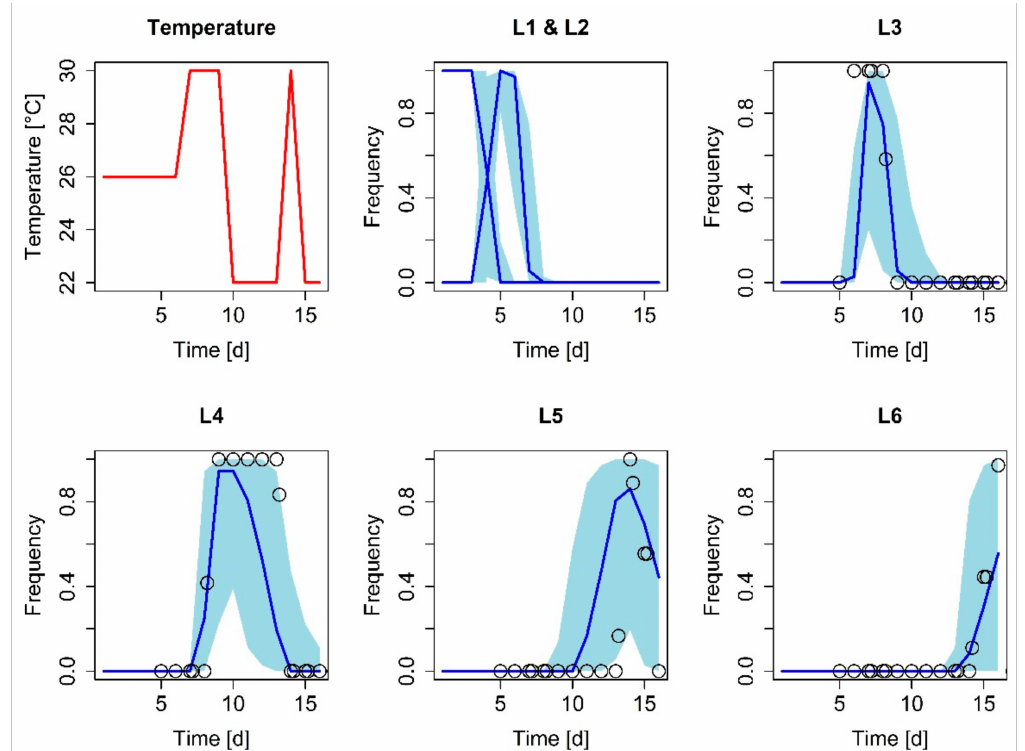
Figure 2. Frequency of the larval instars measured over time in days (d) for an exemplified variable temperature scenario ( red line ). The median and 95% confidence limits of the model prediction are represented by the blue lines and shade areas, respectively. Dots indicate measured data. The instar frequencies were recorded twice per day from instar